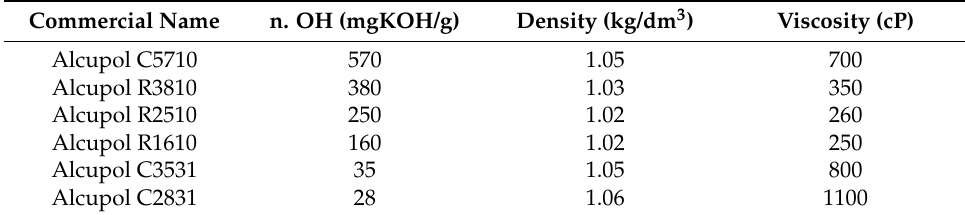
Table 4. Petrochemical polyether polyols Eigenmann &